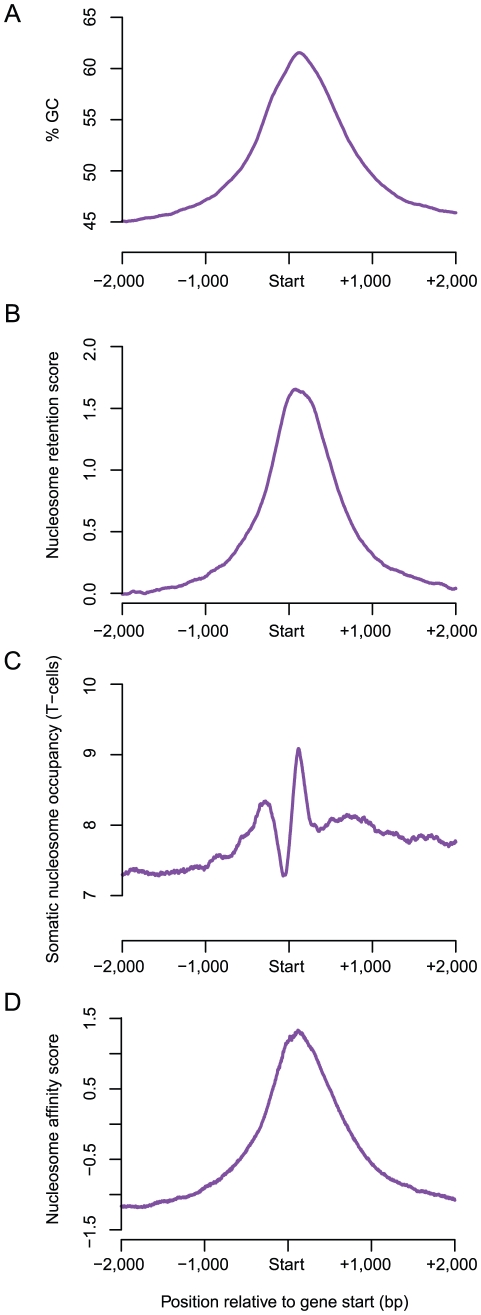
The characteristic GC-content signature of human genes account for sperm nucleosome retention at transcription start sites.Human genes show a characteristic base composition signature with high GC-content at their start sites (A), which correctly predicts high nucleosomes in sperm (B). In contrast, in a somatic tissue (resting T-cells), nucleosomes are positioned around a strong nucleosome free region at the start site, most likely due to transcription related processes (C). The high GC-content of transcription start sites means that they have high intrinsic nucleosome binding preferences (D), which correlates well with nucleosome retention in sperm, but not occupancy in somatic cells. The average plots were generated for the 4 kb region centered at the start site of all human protein-coding genes for the GC-content (A), the normalized nucleosome retention score (B), the predicted binding preferences (nucleosome model score from Kaplan et al) (D) and the shifted somatic nucleosome read count (C) measured in 150 bp windows.